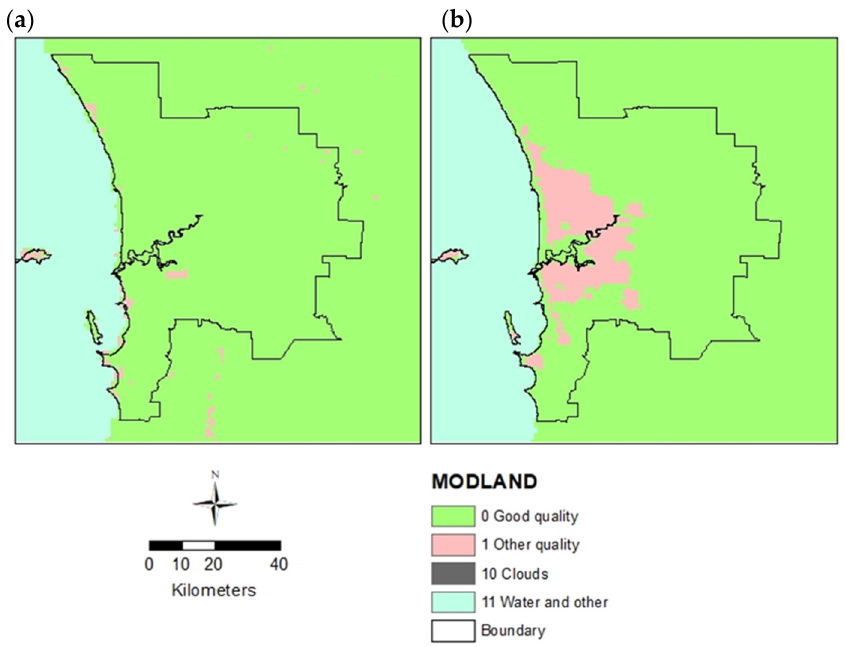
Figure 12. Image date 2019009 , Perth summer, day MODLAND quality comparison: ( a ) MYD21A2 and ( b ) MYD11A2.